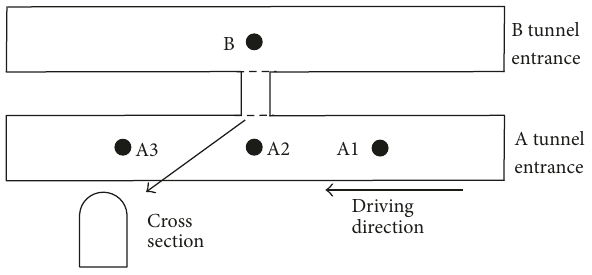
Figure 7: Schematic diagram of train vibration load.